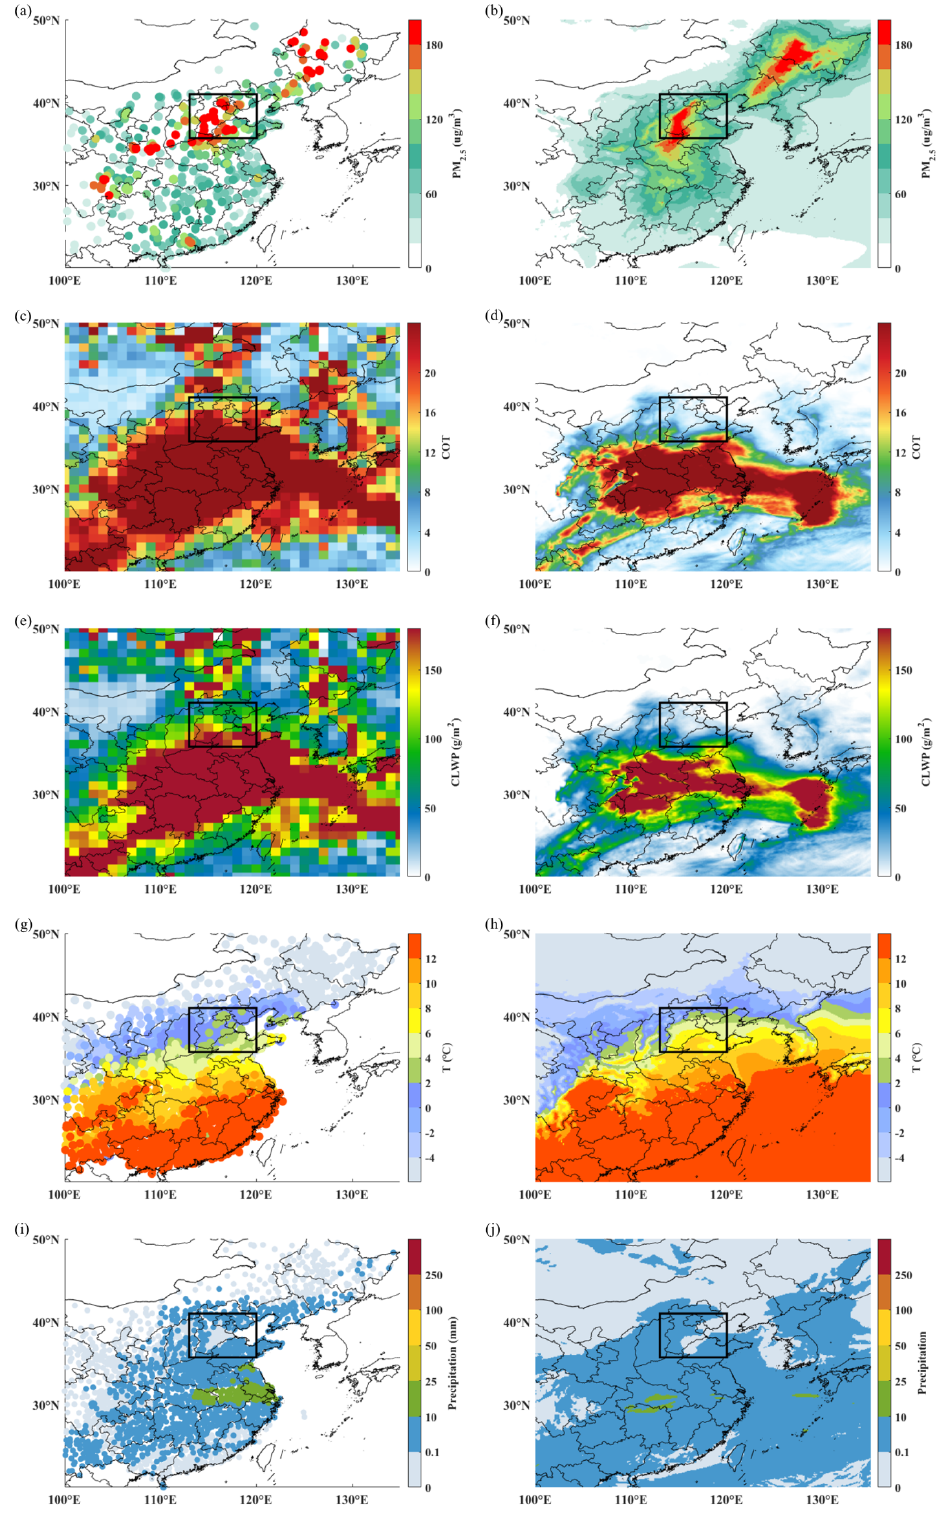
Figure 3. Comparisons of observations (left column) and simulations by the E1 experiment (right column) of mean (a, b) PM 2 . 5 mass concentration, (c, d) COT, (e, f) CLWP, (g, h) 2m temperature in the daytime, and (i, j) 24h cumulative precipitation from 4 to 8 January 2017. The black rectangle represents the location of